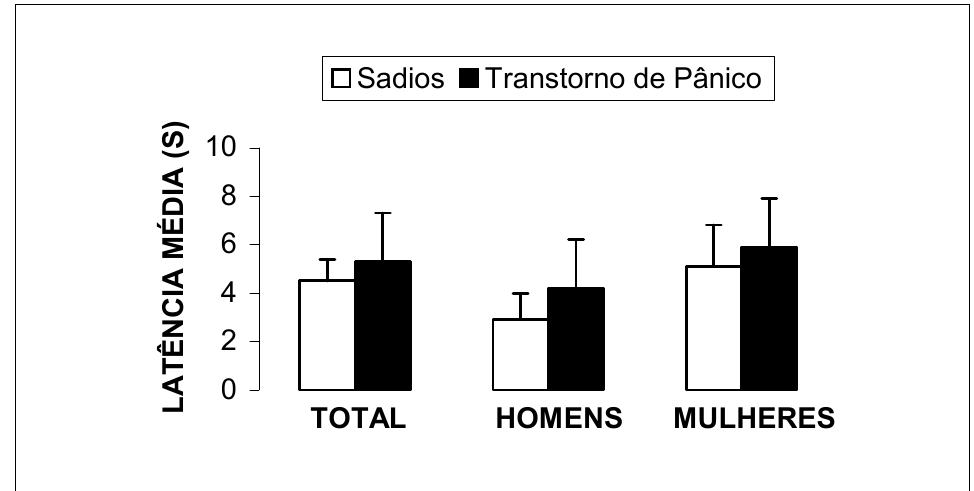
Figura 1 . Média das latências de retirada da mão da água para os participantes sadios e com transtorno de pânico. Linhas verticais representam o erro padrão da média (EPM).